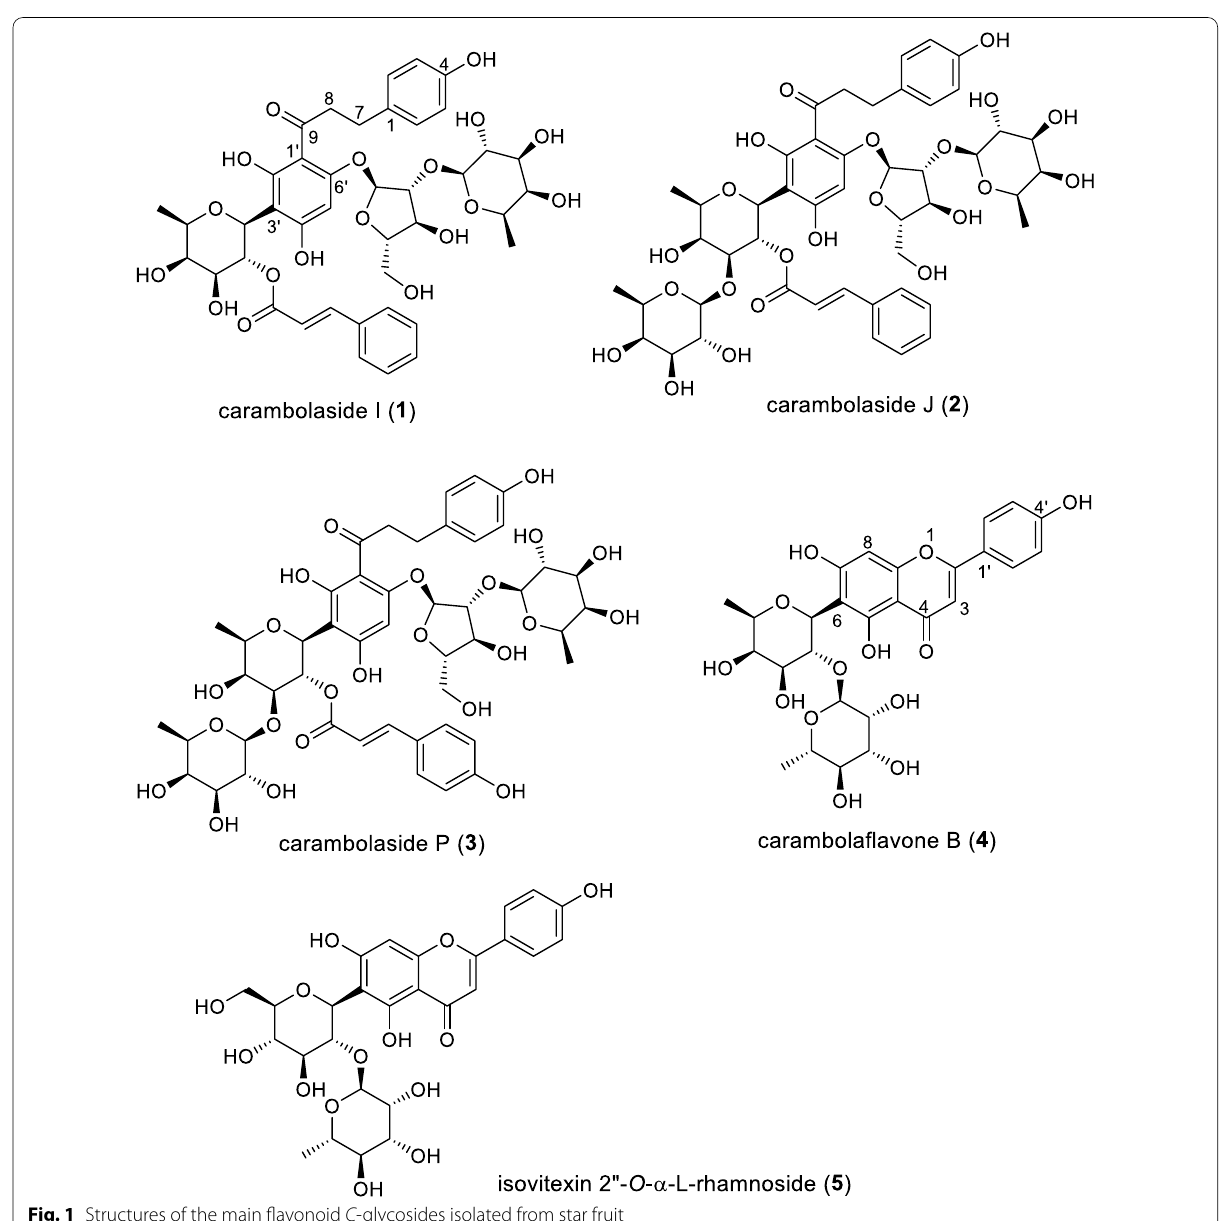
Fig. 1 Structures of the main flavonoid C ‑glycosides isolated from star